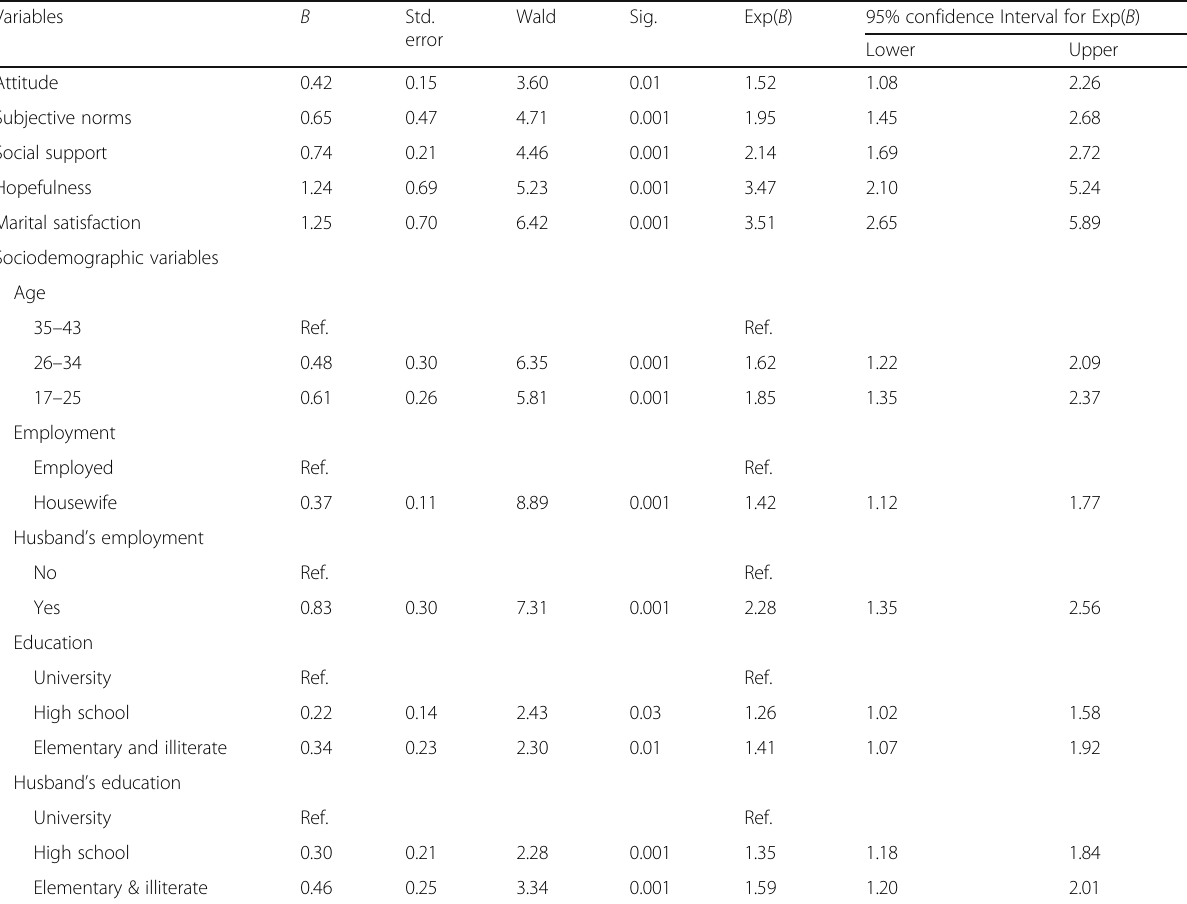
Table 5 Results of the multiple logistic regression analysis of psychological and demographic